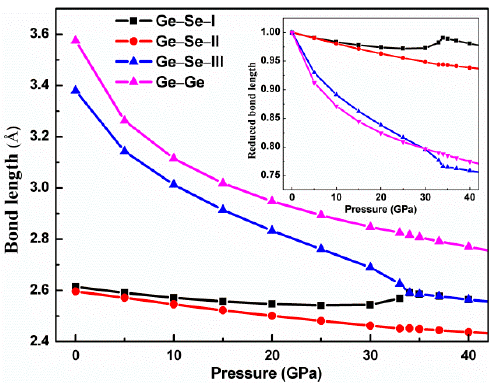
Figure 3. Variations of the bond lengths as a function of the hydrostatic pressure.